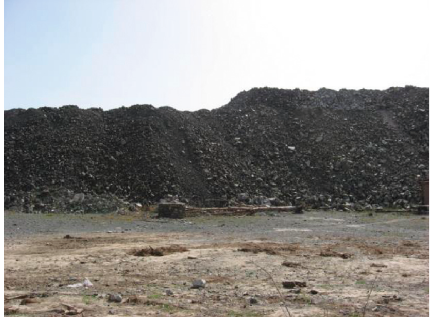
Figure 2: Waste rock